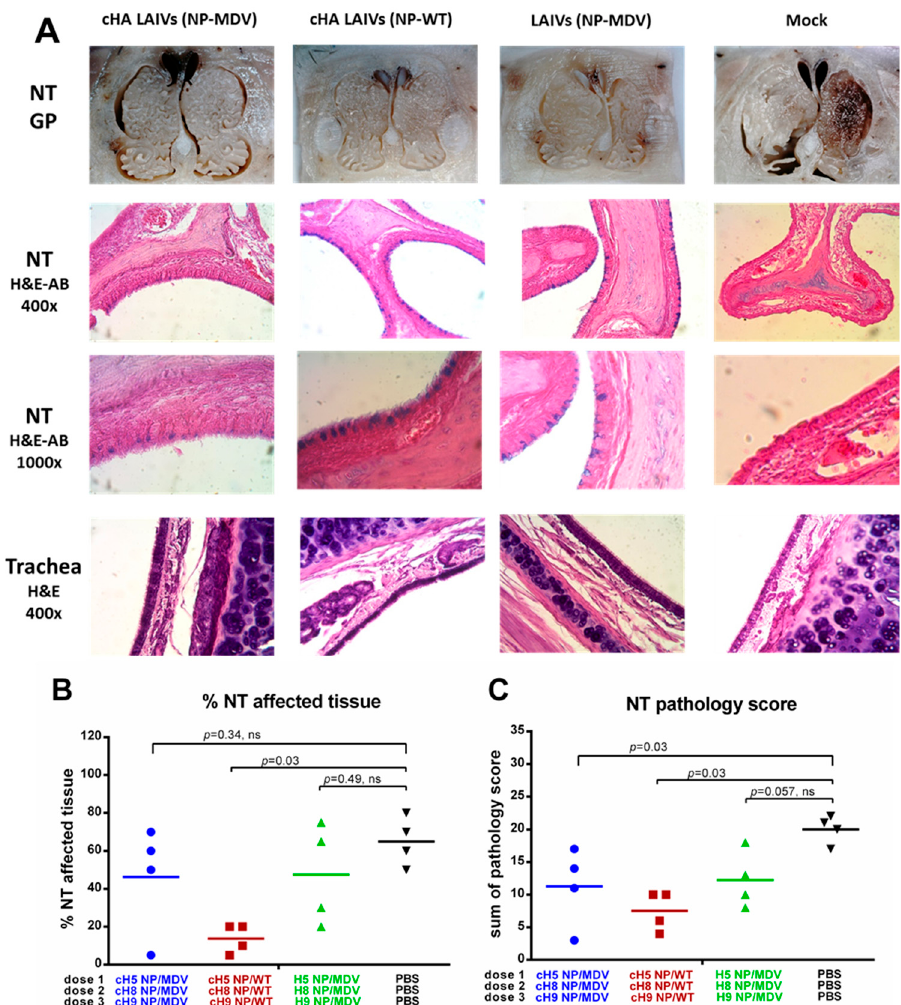
Figure 11. Pathology of the upper respiratory tract of immunized ferrets four days post-challenge. ( A ) Gross pathology (GP) of nasal turbinates (upper panel). Histopathology of NT (middle panel) and trachea (lower panel). ( B ) Percentage affected nasal turbinate tissues. ( C ) Semi-quantitative analysis of NT infection pathology. H&E—haematoxylin and eosin. AB—alcian blue. Statistical differences with mock-vaccinated group are indicated (Mann-Whitney U test); ns = not significant.